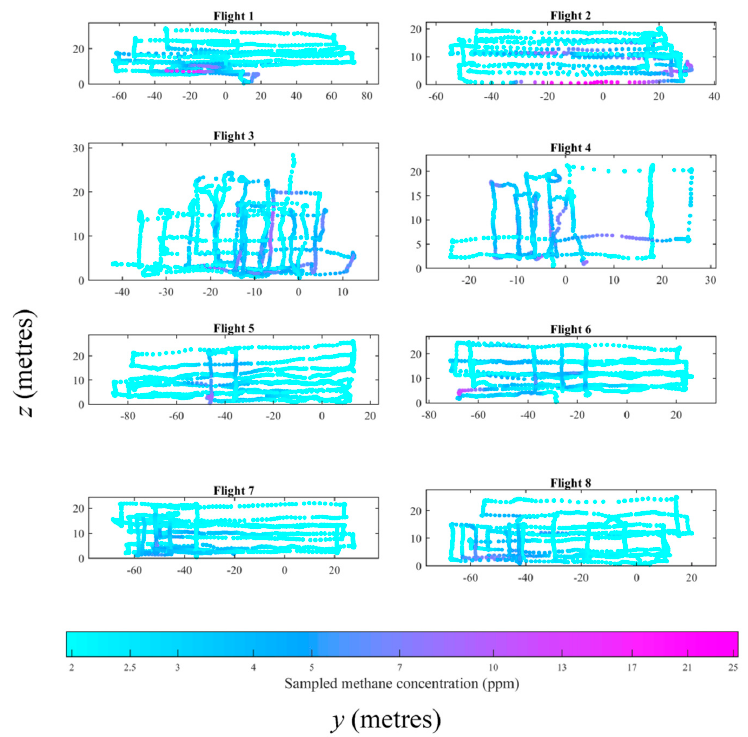
Figure A3. In-situ [CH 4 ] me measurements obtained by the UAV for the sample data, plotted according to geolocation corrected for time lag. Flights are numbered according to assigned flight numbers given in Table S2 in the supplement. A logarithmic color scale has been used. z is plotted on the vertical axis and y is plotted on the horizontal axis.